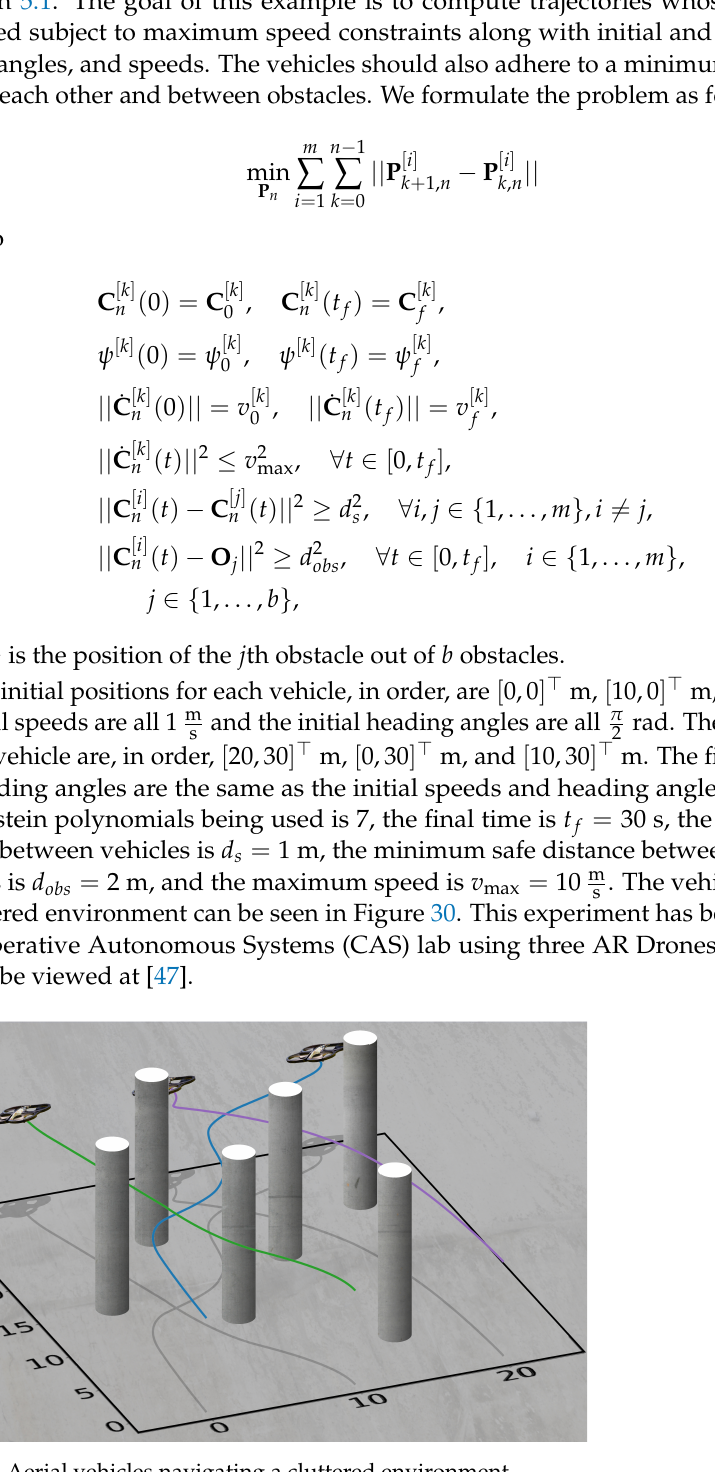
Figure 30. Aerial vehicles navigating a cluttered